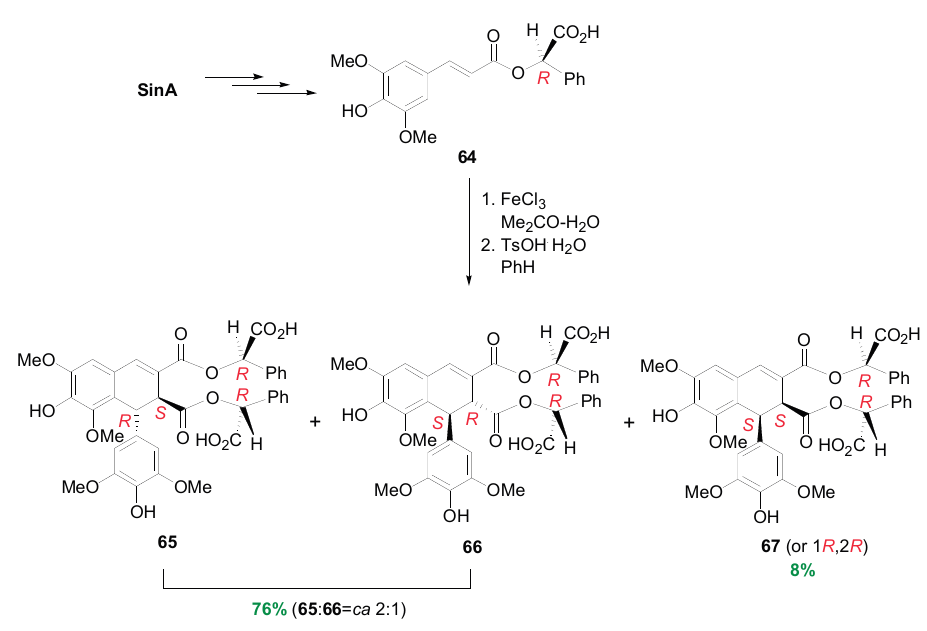
Figure 1. Structures of biologically interesting esters and oligomers of